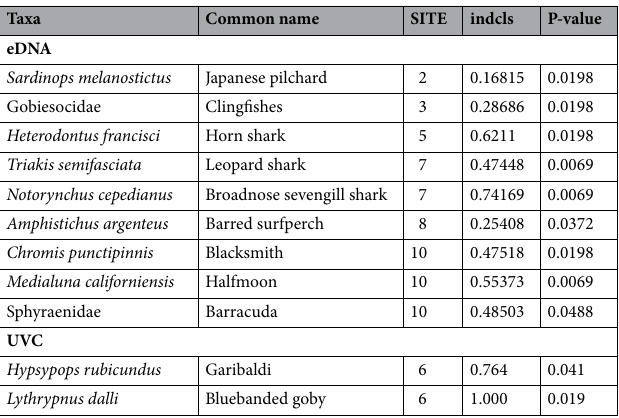
Table 1. List of significant indicator taxa across the 11 sites. For each taxon we provide its indicator value ( indcls ), the site in which it is more prevalent and adjusted probability of obtaining as high an indicator value as observed over 1000